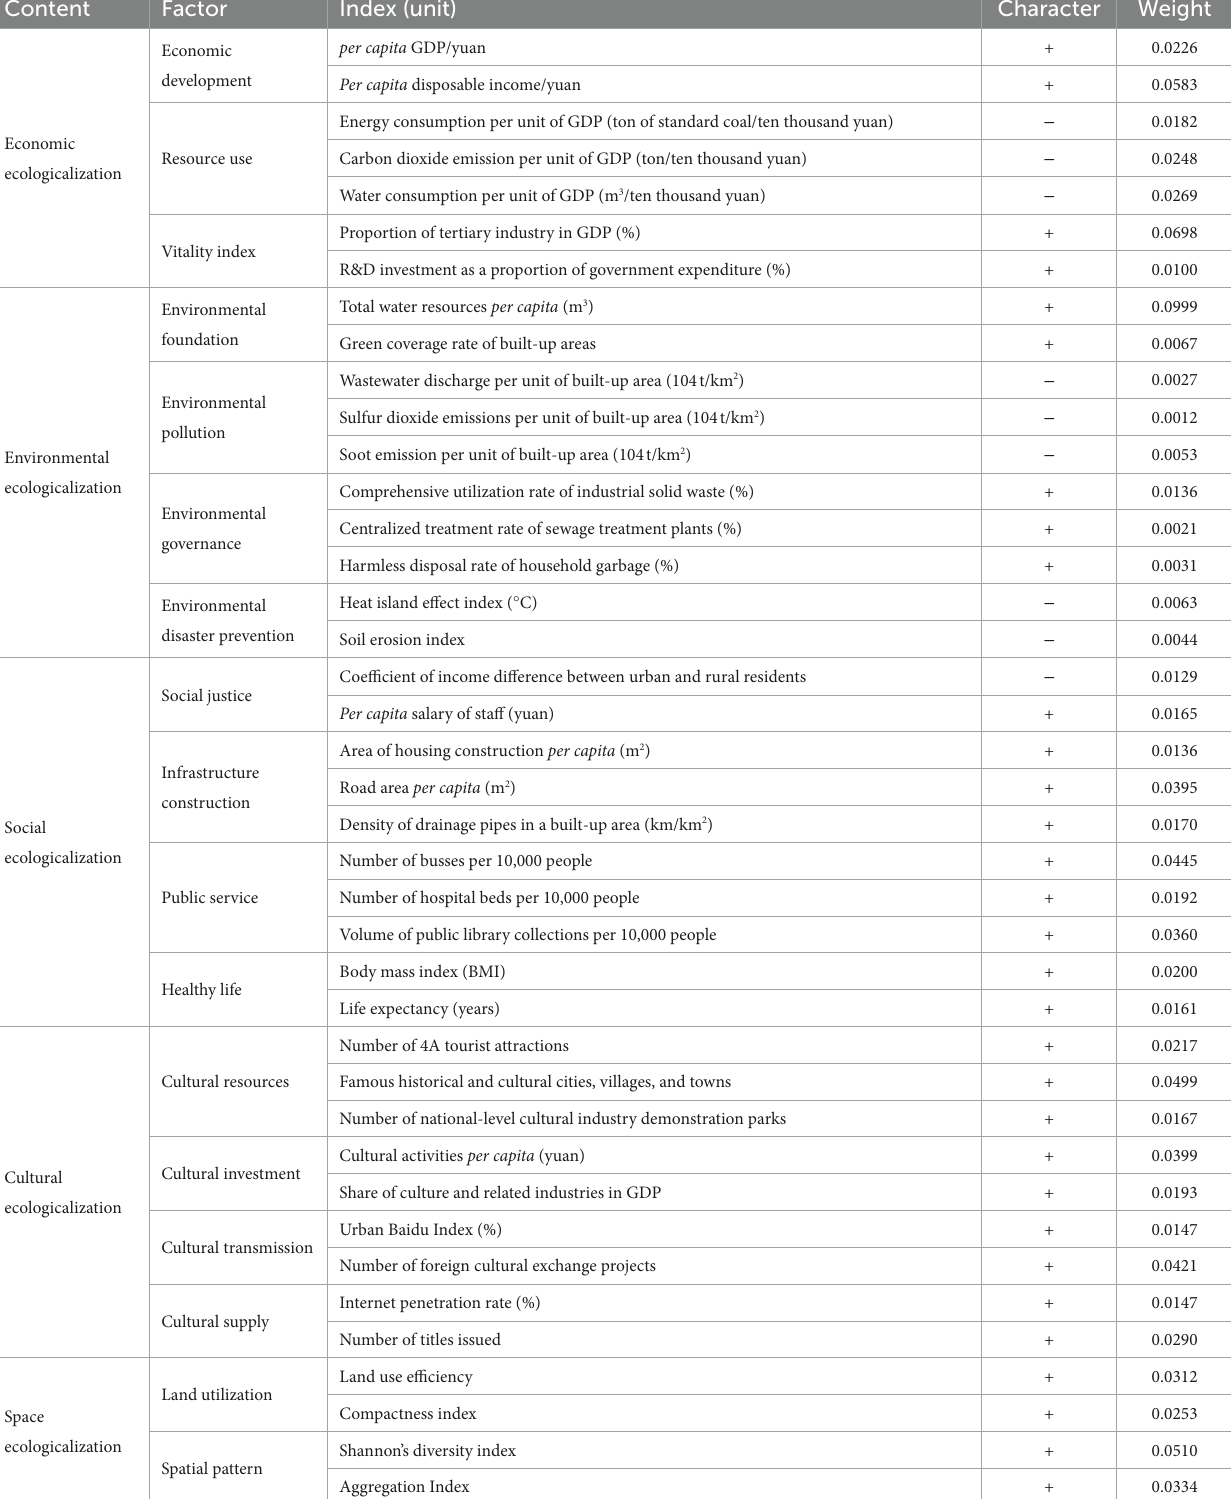
TABLE 1 Assessment index system indicating quality of urban ecological